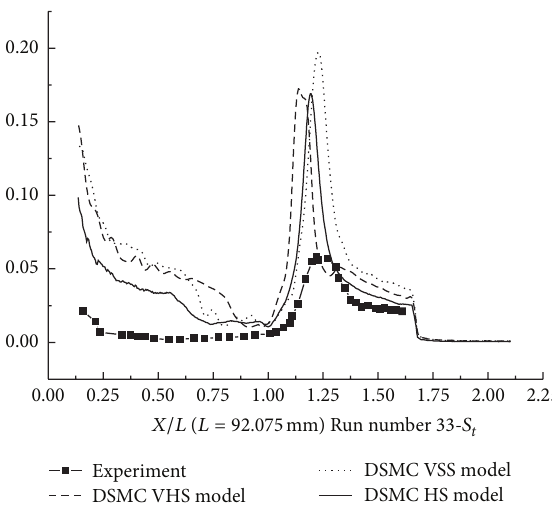
Figure 14: DSMC simulation of Run number 36 ( 𝑆 𝑡 ).